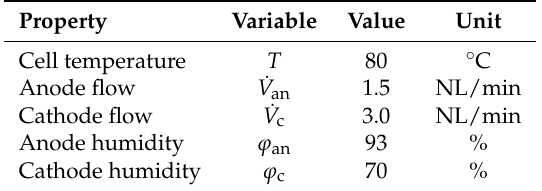
Figure 1. CathodeflowfieldoftheqCF25quickCONNECTfixturewithgeometricdimensions. Thesimplified representation of the flow field, which will be used in the simulation, is highlighted in red. Table 1. Operating conditions as used in the experiments described in [14].